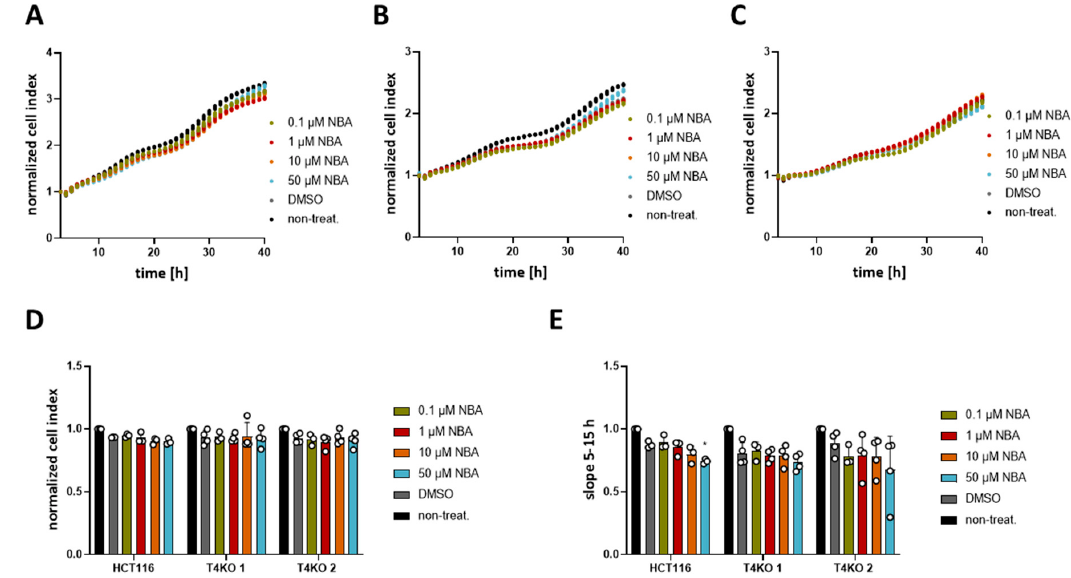
Figure 4. Effect of NBA on HCT116 cells’ proliferation. Cell proliferation was determined with an xCELLigence ® system. Cells were treated with 0.1 µM, 1 µM, 10 µM, 50 µM NBA, or DMSO control. A total of 3–4 independent experiments were performed. ( A ) Mean of cell index was plotted versus time for HCT116 cells. ( B ) Same as ( A ) for T4KO 1 cells. ( C ) Same as ( A ) for T4KO 2 cells. ( D ) Scatter plot and bar diagram of data (mean + SD) at 24 h from the experiment in ( A – C ). ( E ) Scatter plot and bar diagram of slope steepness between 5 and 15 h (mean + SD) from data in ( A – C ). One-way ANOVA was used to determine statistical significance (* p < 0.05) in ( D , E ).